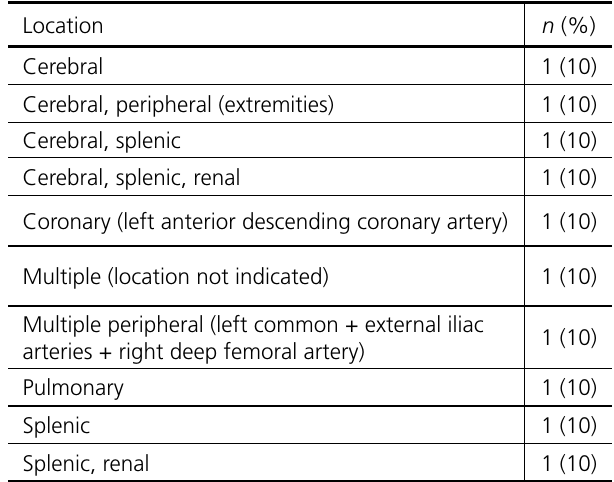
Table 5. Embolic events.